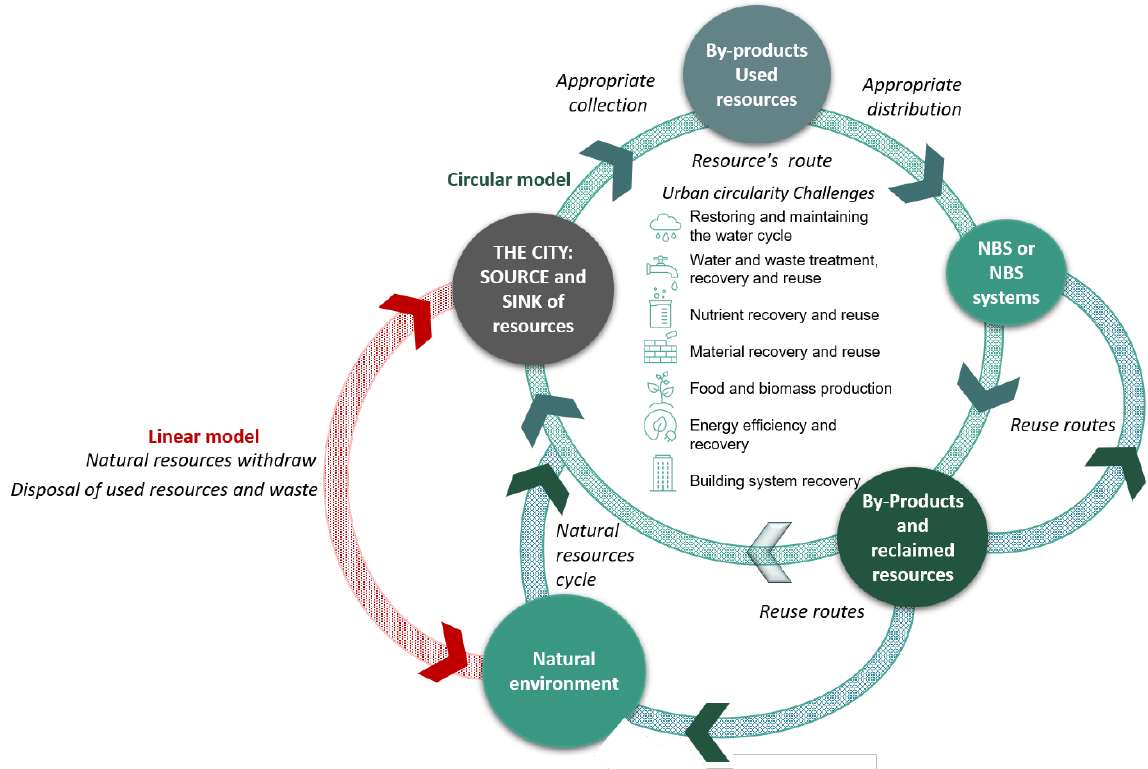
Figure 1. Urban circularity challenges addressed by NBS implemented under a circular framework (adapted from [14]).